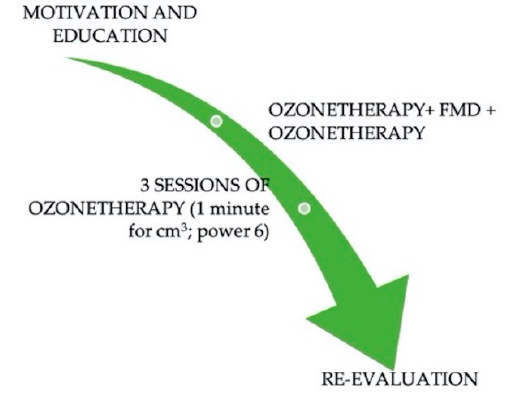
Figure 5. Ozone ad an adjuvant to the modified full mouth disinfection protocol. FMD: Full mouth disinfection.